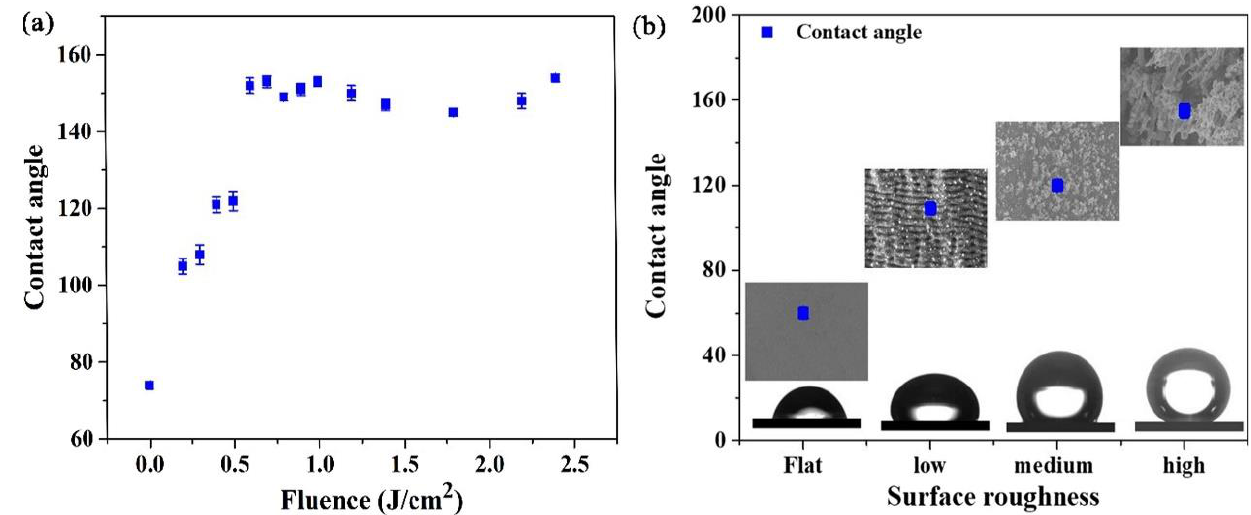
Figure 9. Ref. [93] ( a ) The measured contact angle values as a function of laser fluence. ( b ) The contact angle values measured on the initial surface roughness at low fluence. Corresponding surface morphologies are depicted in the insets.